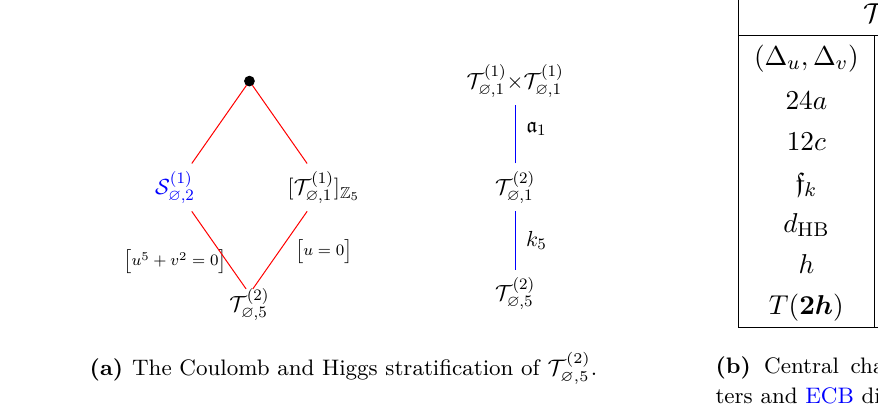
Figure 43. Information about T (2) ?